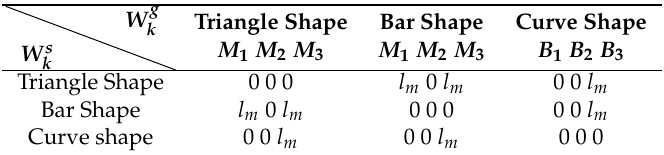
Table 2. The rotating length of each module of hTrihex to shift the robot shape from source waypoint W s to a goal waypoint W g k k